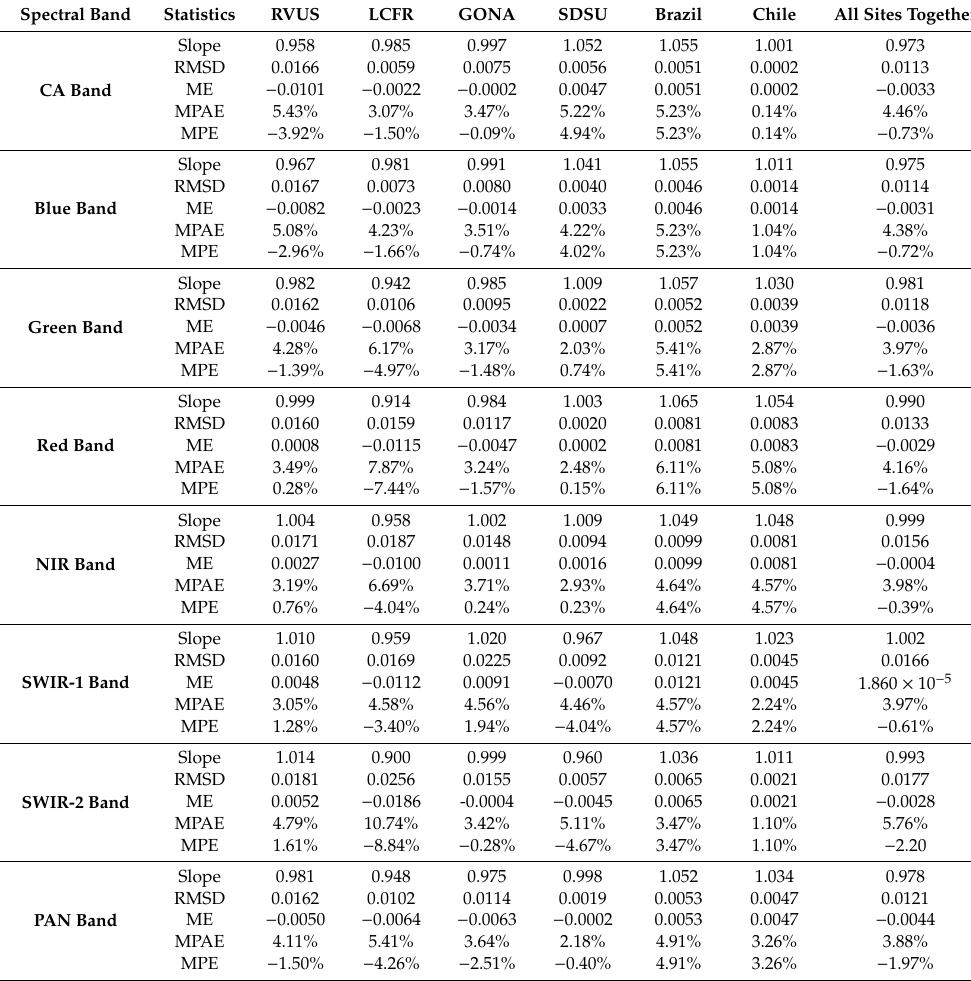
Figure 14. Temporal trends, by band, of residuals errors in TOA reflectance predicted from in situ measurement and Landsat-8 OLI Level-1 TOA reflectance data. Table 3. Comparison between TOA reflectance predicted from in situ measurement and the Landsat-8 OLI data Level-1 TOA reflectance data (Slope, Root Mean Square Deviation—RMSD, Mean Error—ME, Mean Percent Error—MPE; Mean Percent Absolute Error—MPAE).